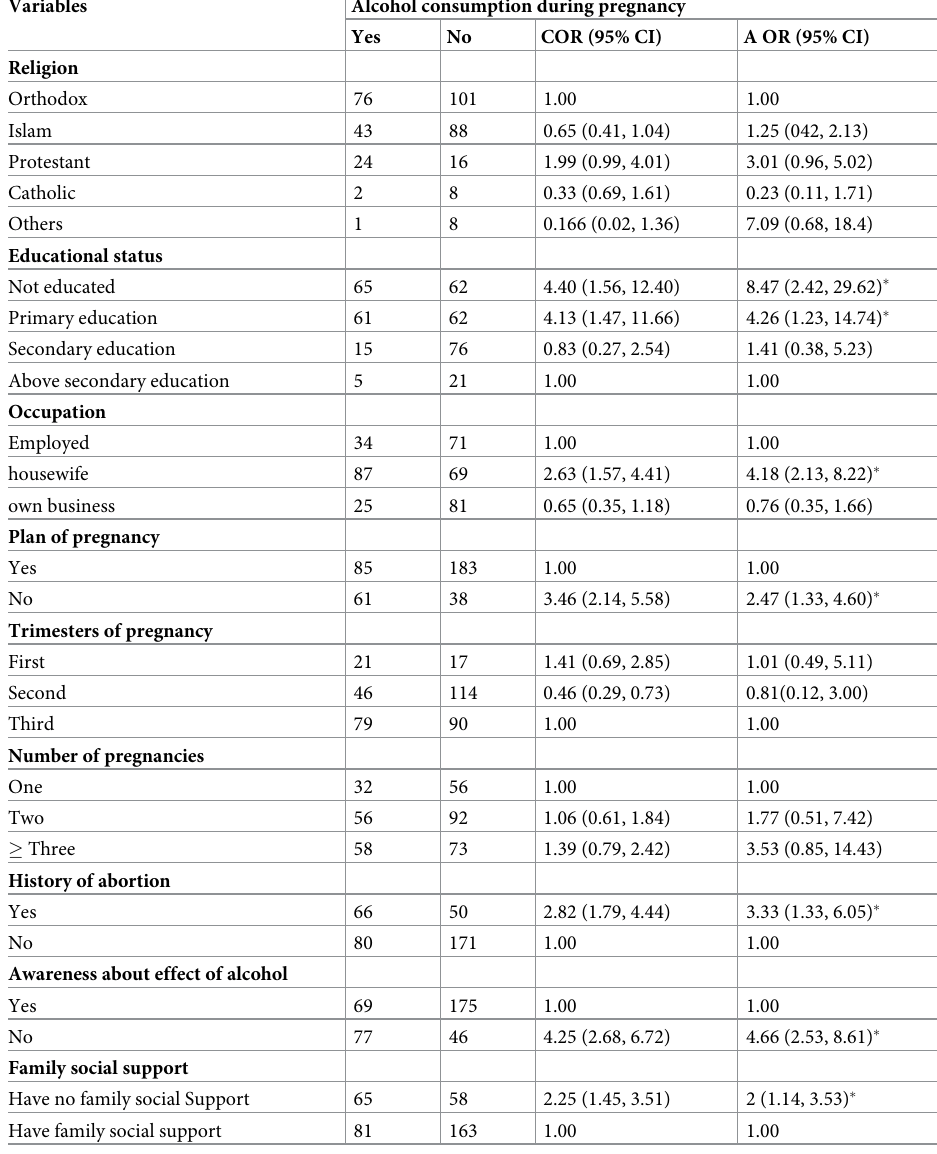
Table 4. Determinants of alcohol consumption among pregnant women in Kolfe Keranio sub city Addis Ababa, Ethiopia (n =